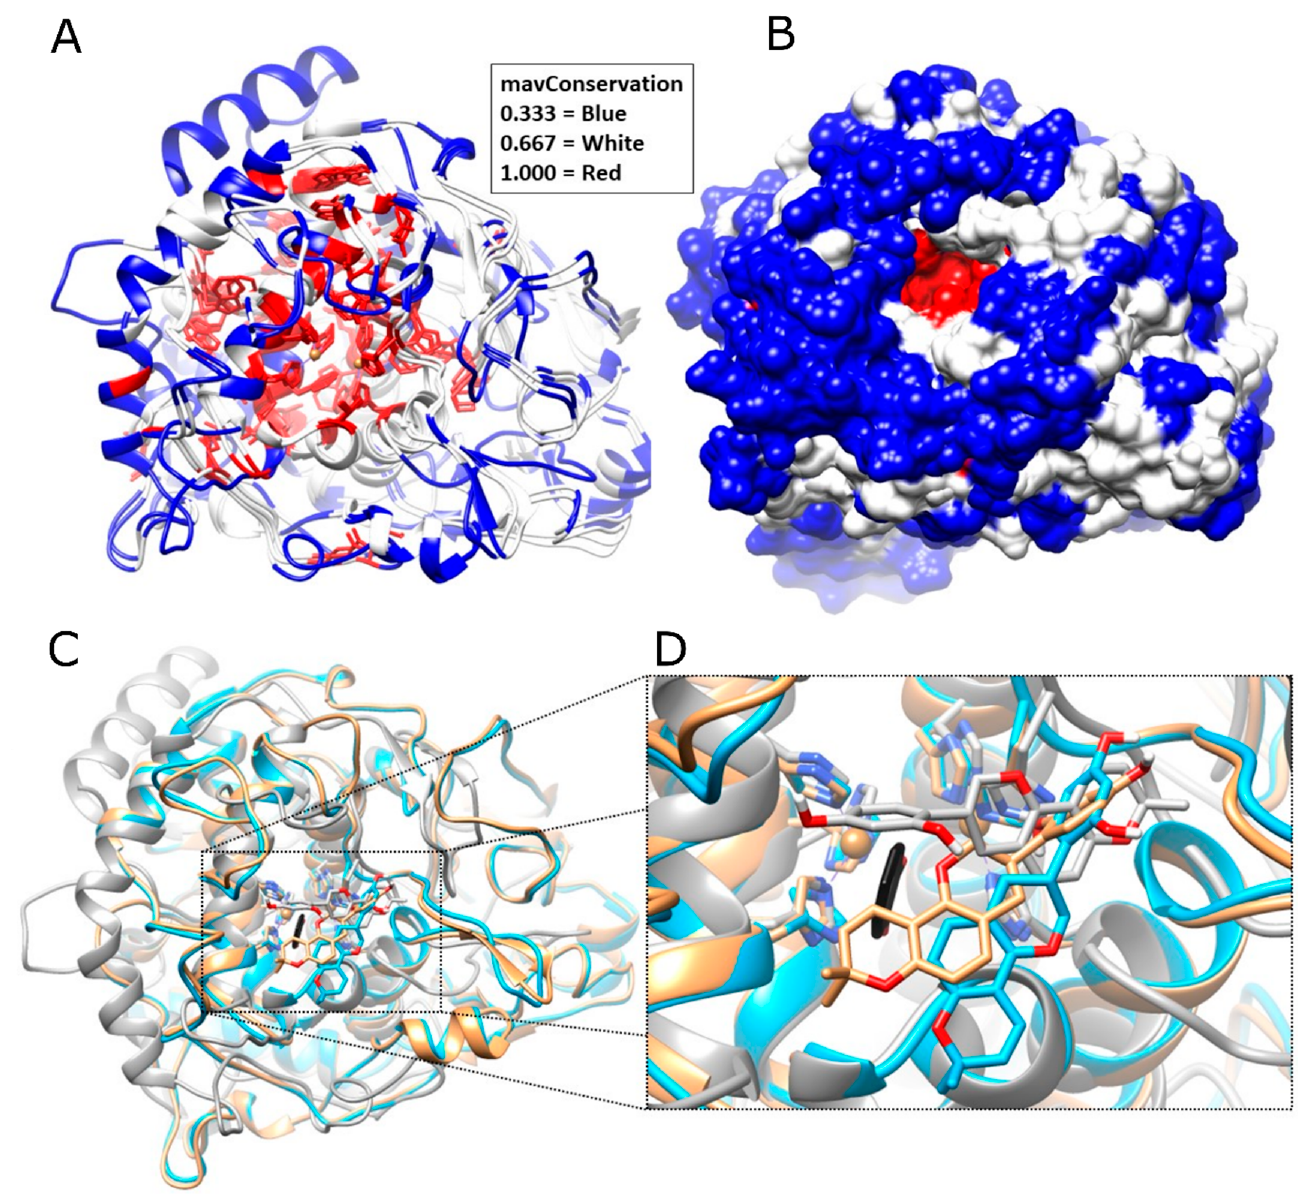
Figure 8. Structural alignment of tyrosinases ( A , B ) and predicted glabridin–tyrosinase complex ( C , D , closed up). ( A , B ) represent the structural alignment of three tyrosinases from mushroom (gray), murine (brown), and zebrafish (blue) in cartoon and surface formats. The mavConservation score is used (in A , B ) to determine the degree of conservation among tyrosinases. For example, red represents a value of 1, indicating high conservation (active site). Blue represents a value of 0.333, indicating low conservation. White represents a value of 0.667, indicating medium conservation. ( C , D ) exhibit a predicted enzyme-inhibitor complex between glabridin and tyrosinases. Gray indicates a glabridin– mushroom tyrosinase. In comparison, brown represents a complex between glabridin–murine’s tyrosinase. Finally, blue exhibits a complex from zebrafish’s tyrosinase and glabridin. Tropolone (Black, a native competitive tyrosinase inhibitor) indicates a catalytic site on aligned tyrosinases [20]. Finally, the authors performed molecular docking on a mushroom, murine, and zebrafish tyrosinase. The best docking pose of each tyrosinase was selected after combining and overlaying docking results of glabridin and its derivatives (3 (cid:48) ’,4 (cid:48) ’-dihydroglabridin and morusone). Previously, both glabridin derivatives had been reported with an anti- tyrosinase activity. Therefore, overlaying docking results of glabridin and its